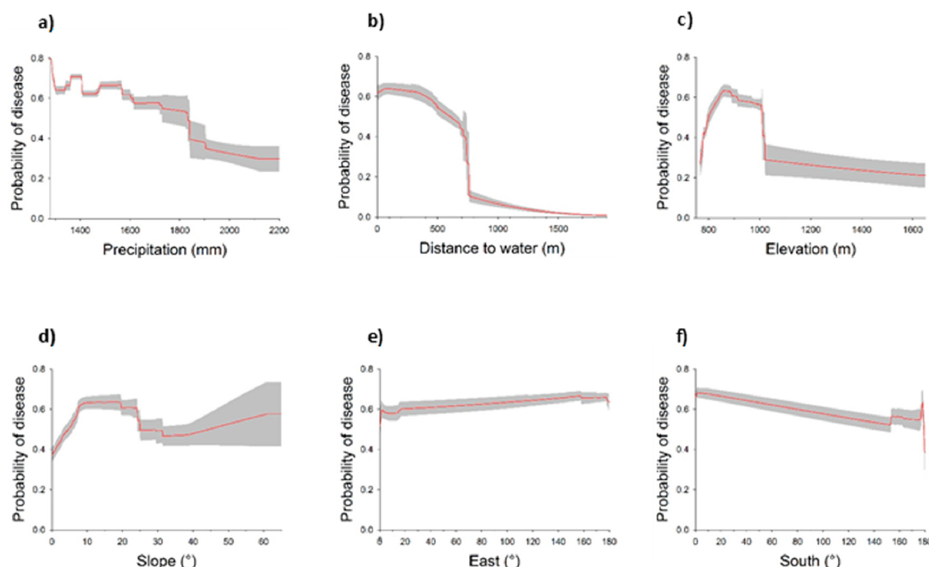
Figure 4. Austrocedrus disease risk according to MaxEnt algorithm in function of environmental variables. Mean value ± 1 standard deviation (gray area) is shown. Environmental variables (axis x) include: mean annual precipitation ( a ), distance to water courses ( b ), elevation ( c ), slope ( d ), relative east aspect ( e ) and relative south aspect ( f ).